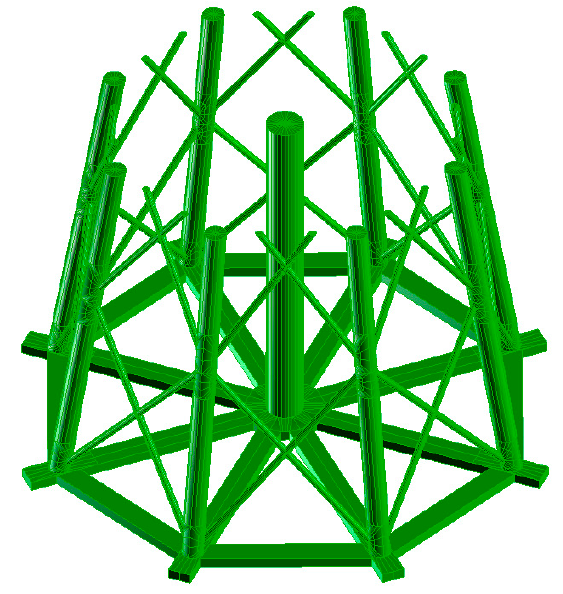
Figure 4. Modeling of wetted surfaces of FOWT-SFFC in MultiSurf.